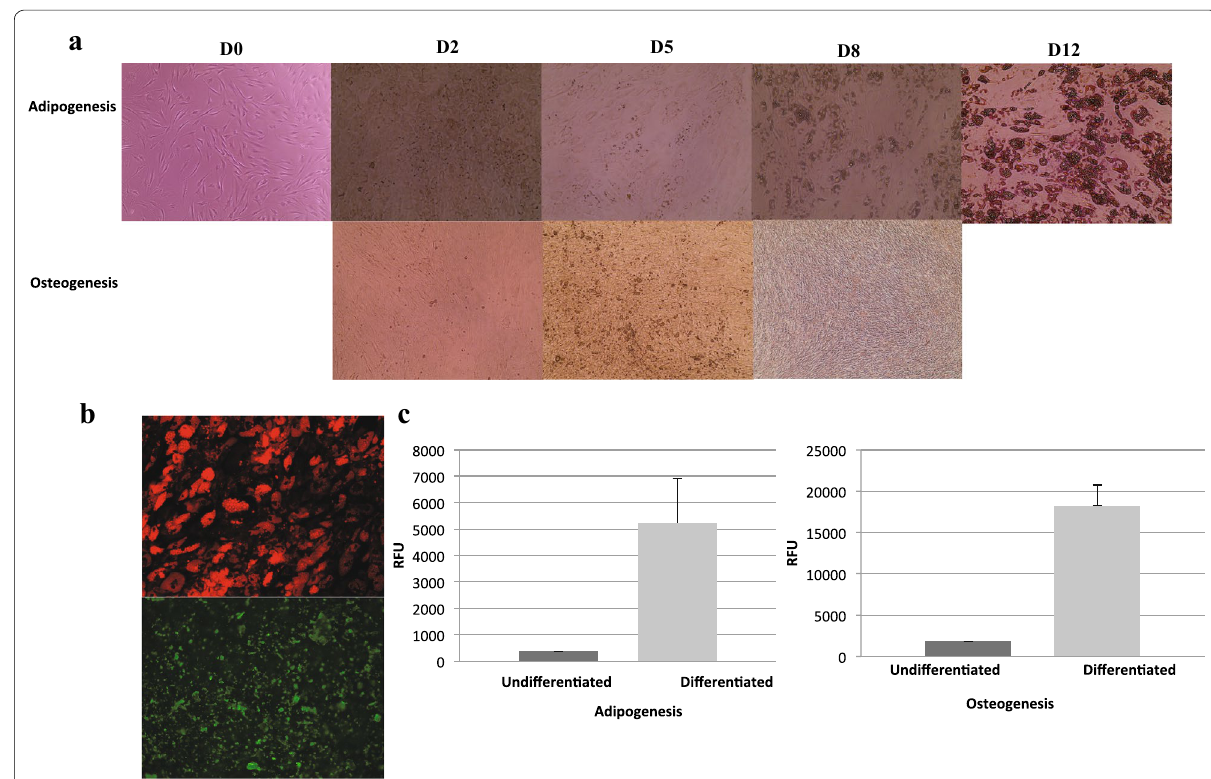
Fig. 5 The differentiation potency analysis of ADE-MSCs. a , b Morphological analysis of in vitro differentiation of ADE-MSCs (P1) under adipogenic and osteogenic media conditions using light microscopy ( a ) and fluorescence microscopy ( b ). c The quantification of the accumulation of intracel- lular triglycerides and calcium deposit in adipogenesis and osteogenesis, respectively. RFU represents relative fluorescence unit read in both of the culture conditions; undifferentiated versus differentiated. Error bars are standard deviations from four independent samples. The P values were calculated using the Student t test. (*p < 0.05 for adipogenesis and **p < 0.02 for